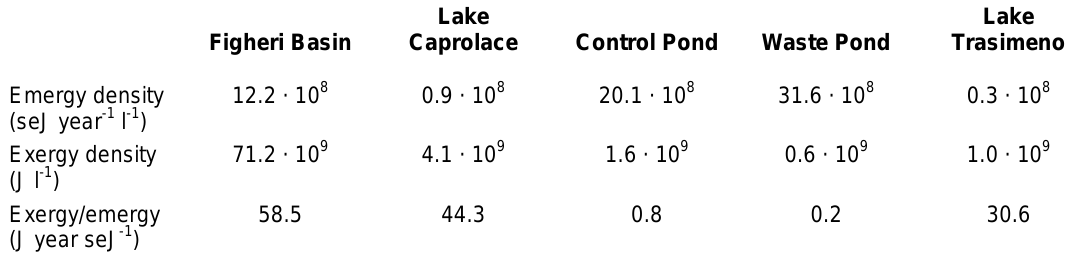
Exergy, Emergy Density, and Their Ratio for Five Ecosystems Lake Figheri Basin Caprolace Control Pond Waste Pond